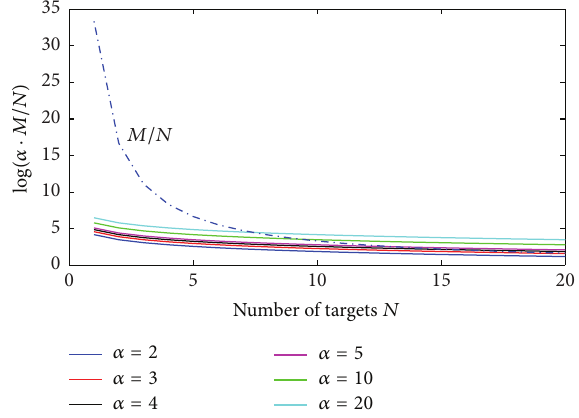
Figure 5: Behavior of (18) for the case 𝐵 = 500 MHz, Δ𝑓 =